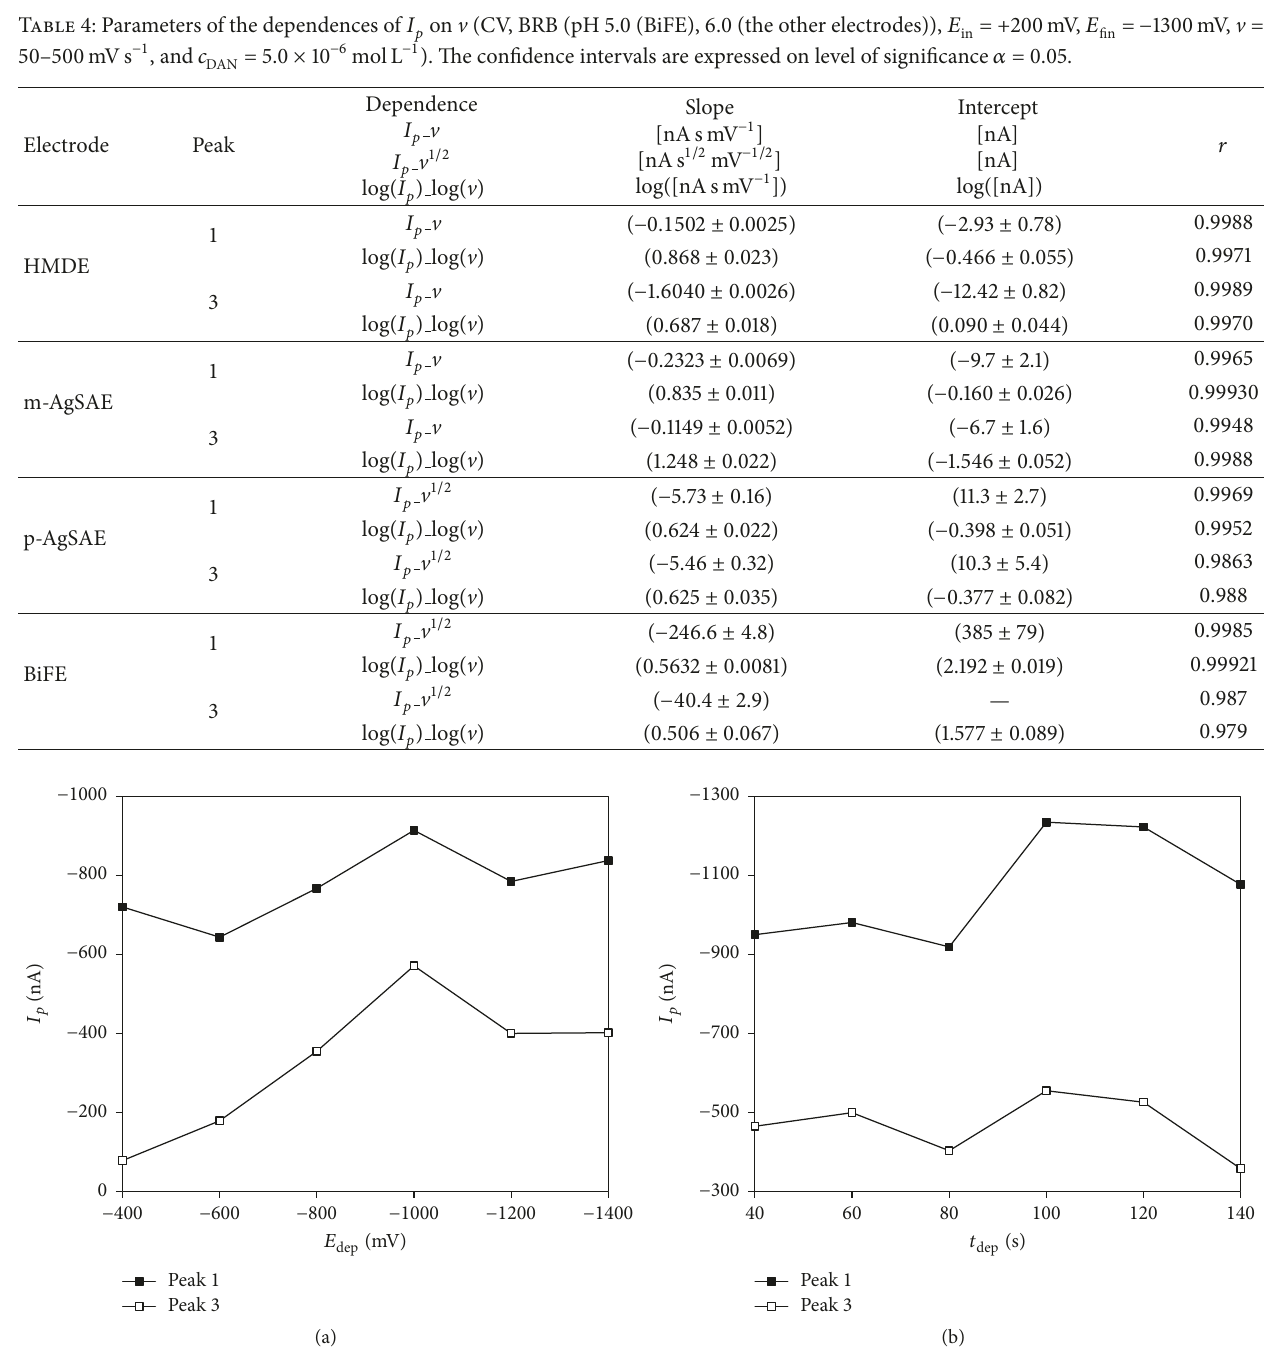
Figure 5: Optimization of 𝐸 V = 40 mVs −1 ; pulse height = − 50 mV; pulse width = 60 ms; 𝑐